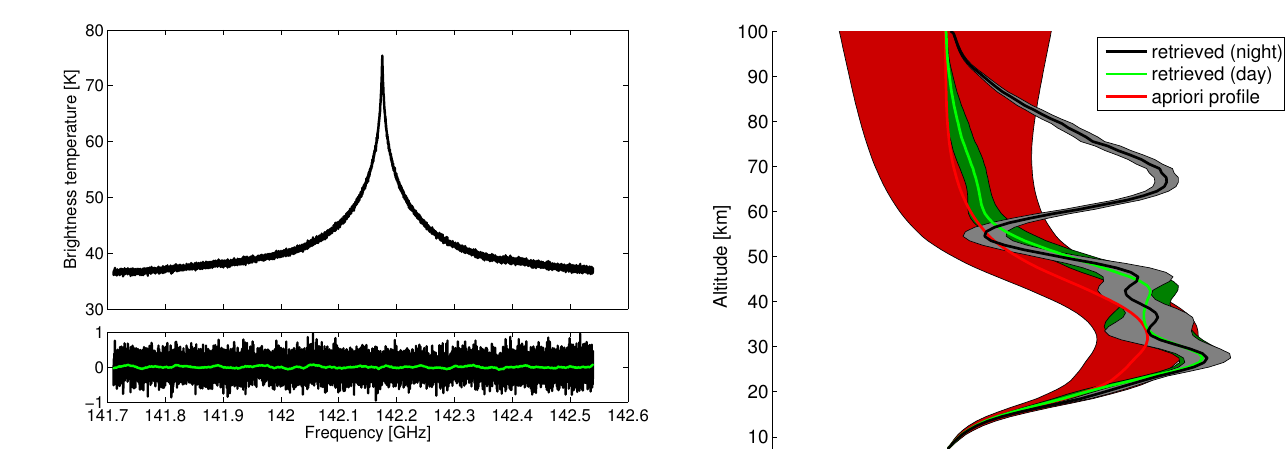
Fig. 3. A spectrum measured on the 25 February 2009, mid night (UTC). The lower figure shows the residuum after profile retrieval (See Fig. 4). A running mean has been applied to the residuum.